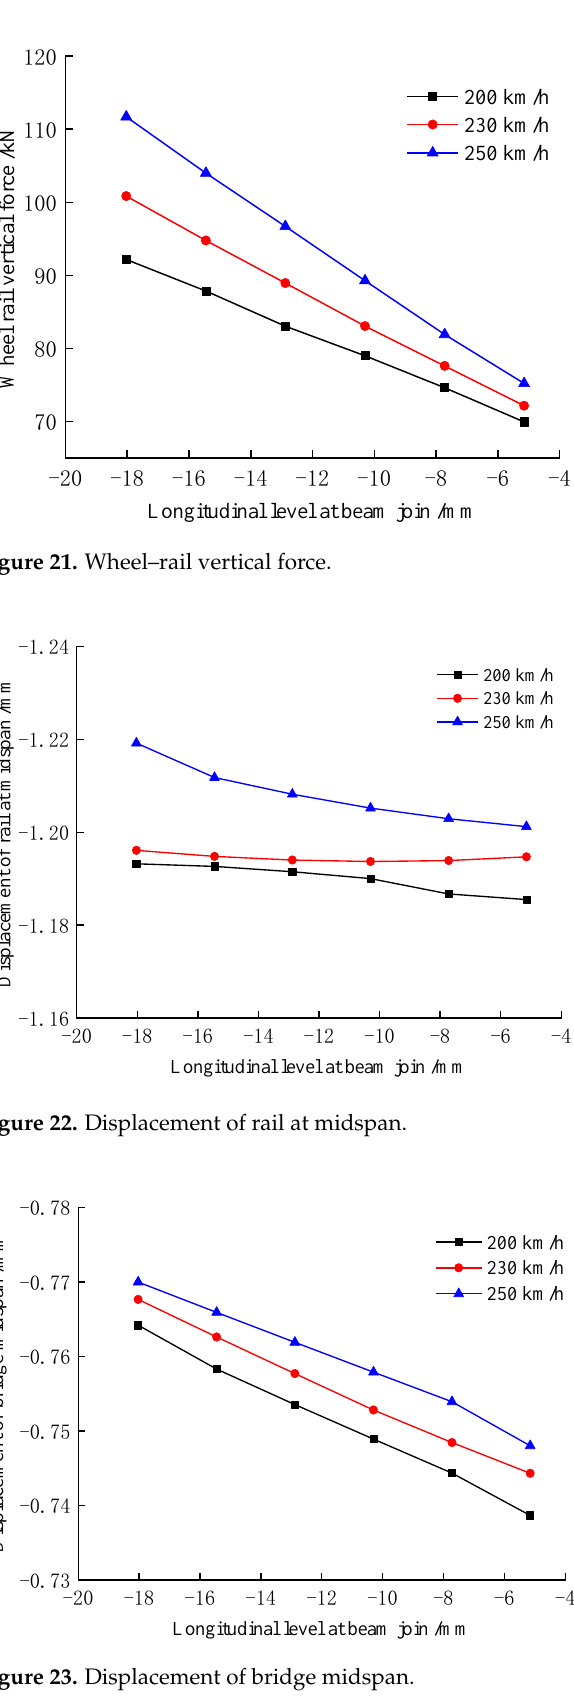
Figure 20. Rate of wheel load reduction.